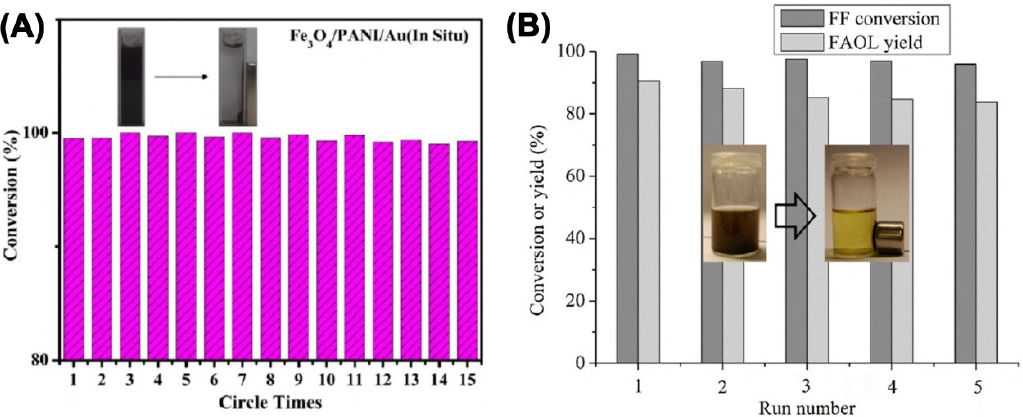
Figure 10. ( A ) Recycling tests of Fe 3 O 4 /PANI/Au in catalytic reduction of 4-NP [112], Copyright 2021 Wiley. ( B ) Recyclability of Al 7 Zr 3 @Fe 3 O 4 in the synthesis of FAOL from FF [120], Copyright 2018 Wiley.